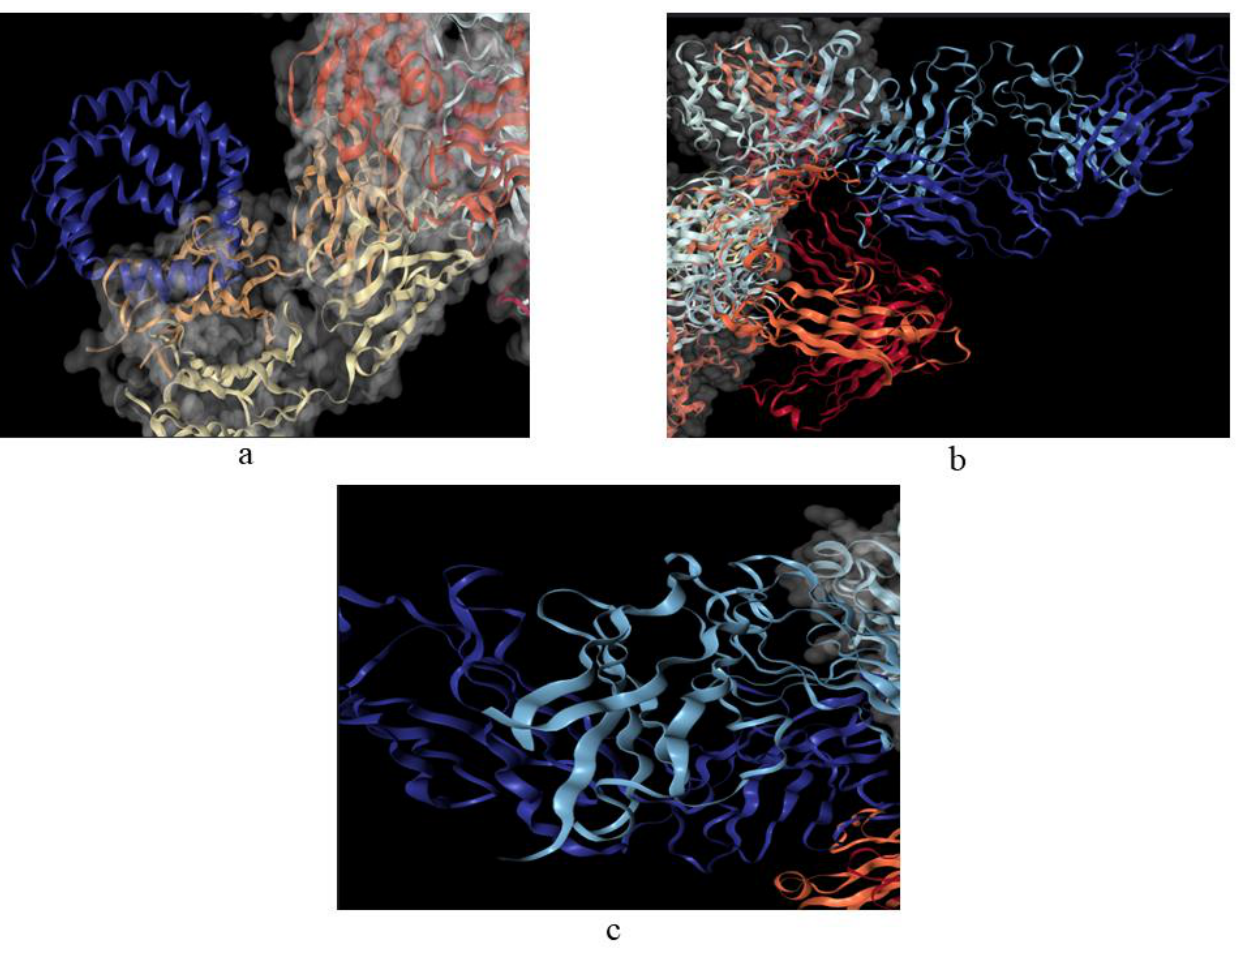
Figure 1. Visualization of docked complexes of ( a ) Blag 1.0101-IgE ( − 19.08 kcal/mol), ( b ) Per a 1.0102-IgE ( − 21.33 kcal/mol), and ( c ) Per a 7-IgE ( − 19.71 kcal/mol). IgE is represented as a complex molecule, and selected protein allergens are visualized as blue polypeptide chains.